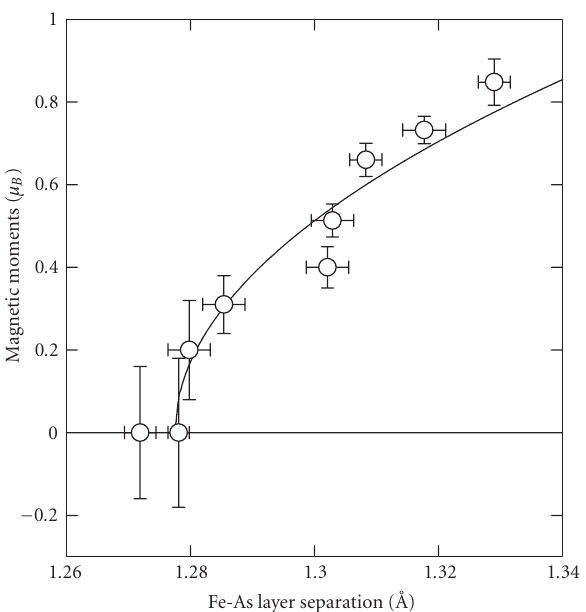
Figure 3: Electron energy as a function of the Fe-As layer separation As 2 , with spin polarization; is calculated by LDA for Ba(Fe 0 . 92 Co 0 . 08 ) 2 the elastic constant is reduced by 29% compared to the state without spin polarization, accounting for the phonon softening by 15% due to spin